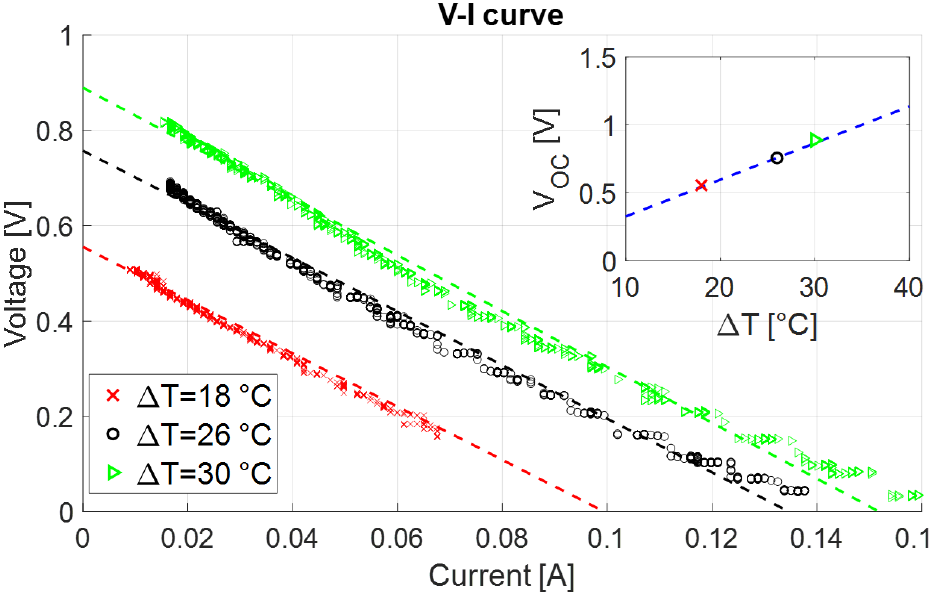
Figure 3. V-I characteristic curve measured (scatter plots) and fitted (dashed lines) at three tempera- ture gradients: ∆ T = 18 °C (red plots), ∆ T = 26 °C (black plots) and ∆ T = 30 °C(green plots). In the inset, the OC voltage V OC at the three temperature